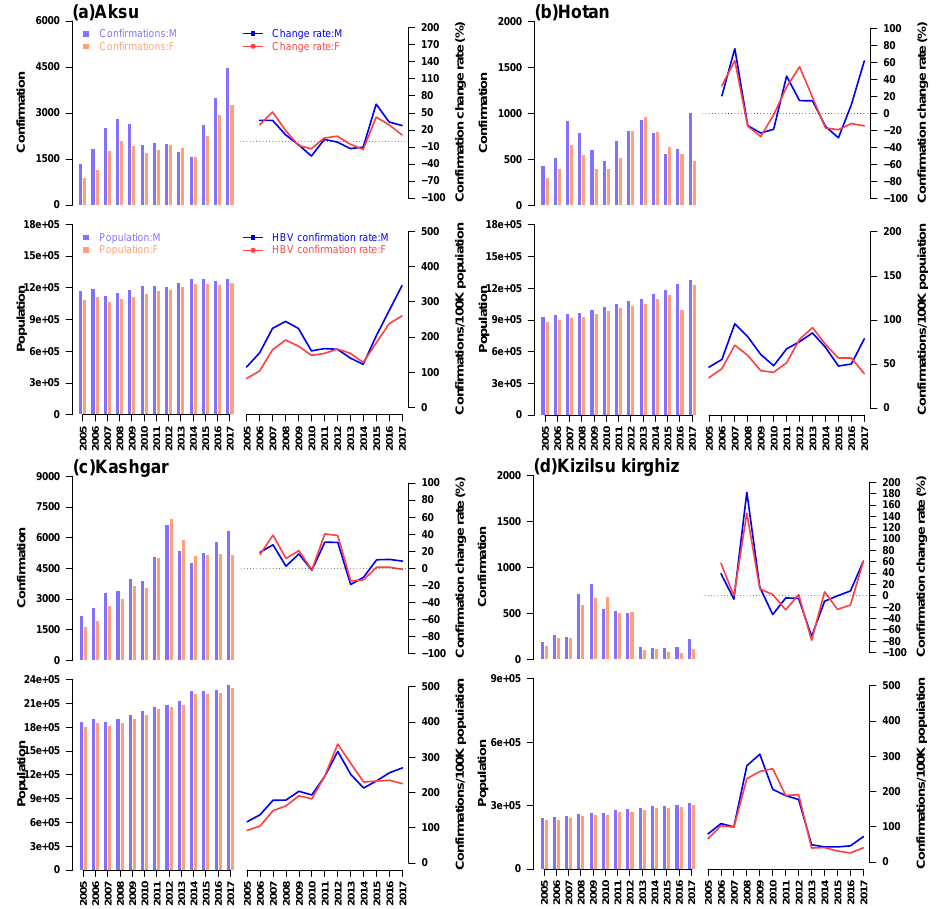
Figure 2. A description of the total population and the population with HBV from 2005 to 2017 in four regions of Xinjiang, China. Blue stripes and lines denoted men, red stripes and lines denoted women. In each group, for men and women, the upper bar chart showed the number of cases of HB, the upper bar showed the change rate of HB incidence, the lower bar chart showed the annual population of the region, and the lower bar showed the incidence rate of